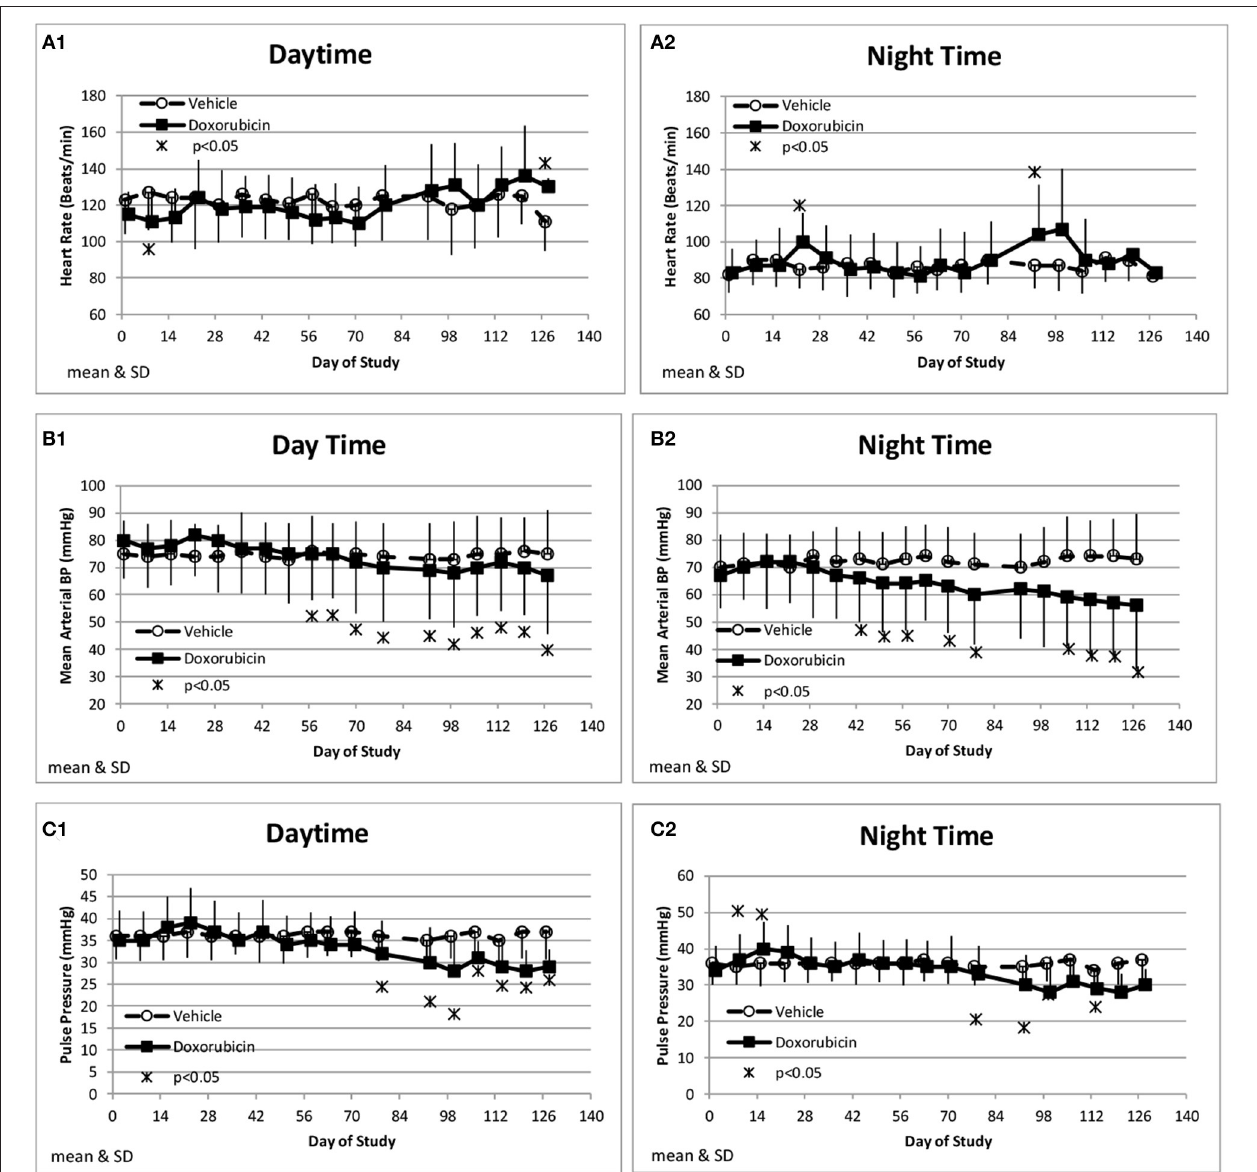
FIGURE 3 | Hemodynamic changes. Changes in heart rate (A) , Mean Blood Pressure (B) , and Pulse pressure (C) averaged over the day (1) and night (2) time frames over the course of the study.